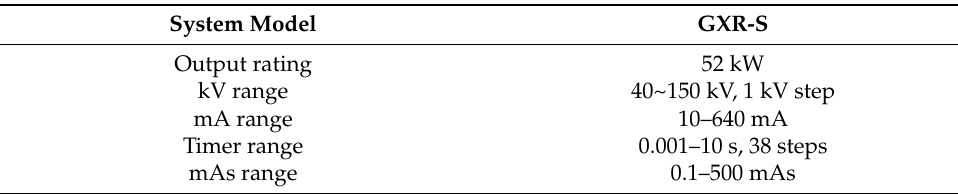
Table 2. Specifications of the X-ray system.